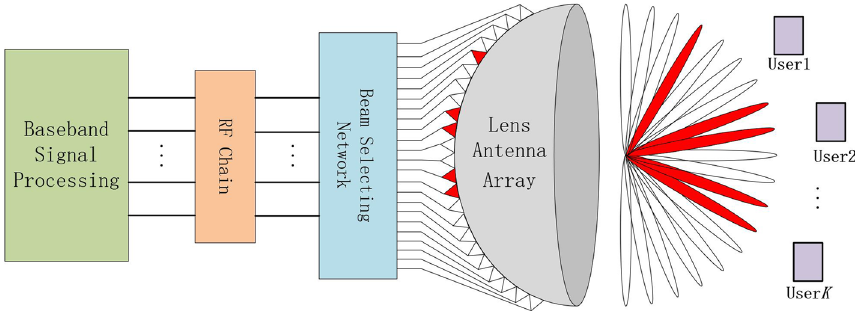
Fig. 1 Block diagram of a wideband mmWave massive MIMO-OFDM system with a lens antenna